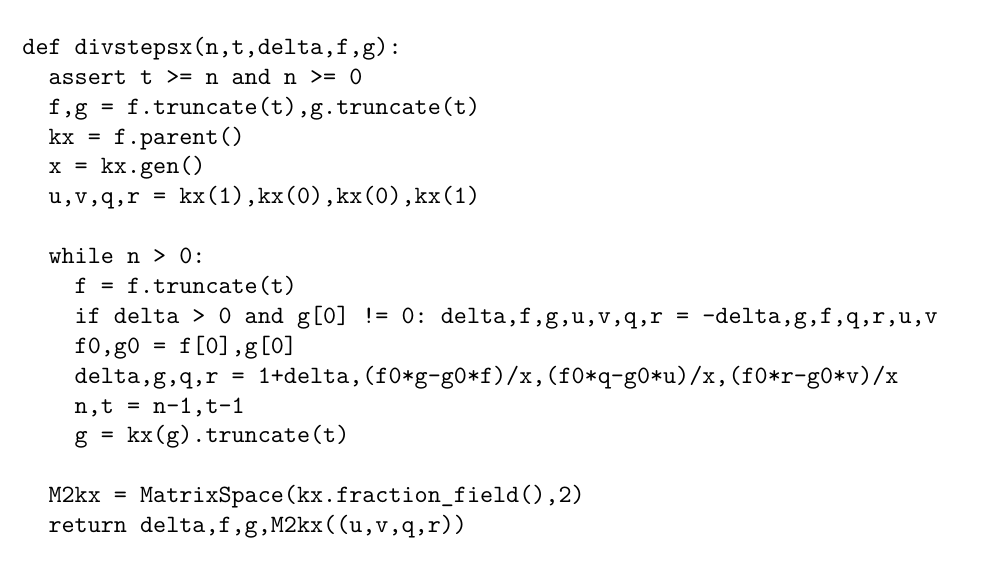
Figure 5.1: Algorithm divstepsx to compute ( δ n , f n , g n ) = divstep n ( δ, f, g ).